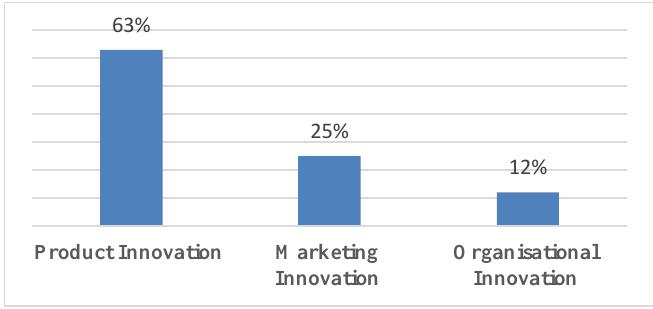
Figure 12: Types of Innovation ; Source: Author